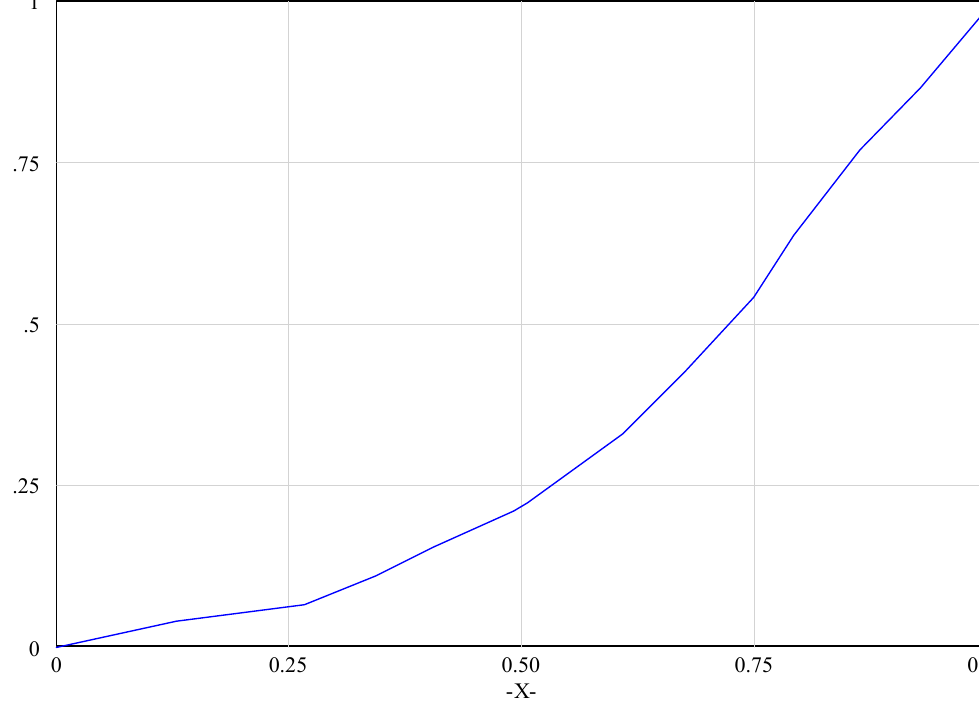
Figure A4. Normalized effect of temperature change on per capita energy demand.